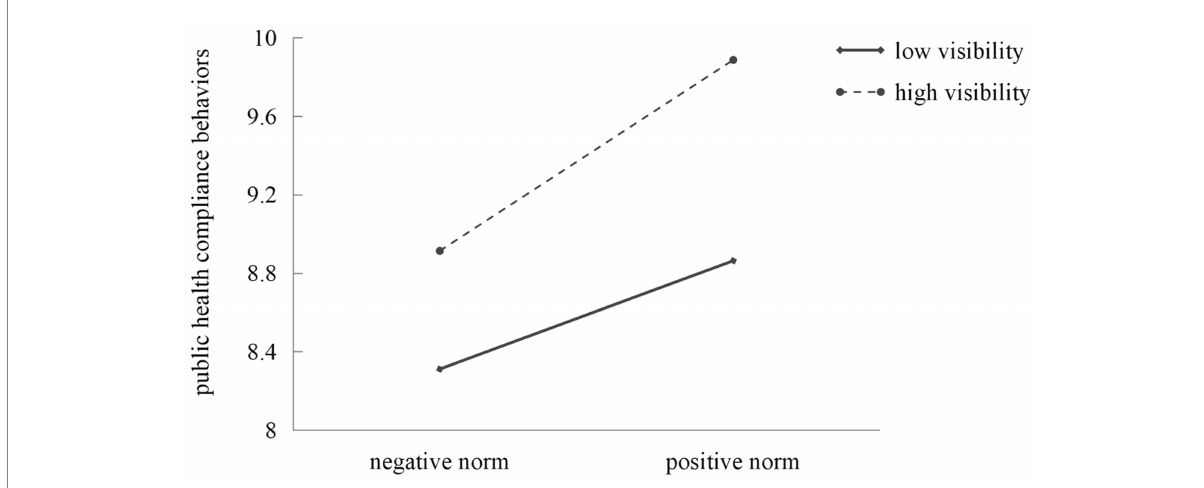
FIGURE 5 The interaction effect of the property of descriptive norms and the behavioral visibility on public health compliance behaviors.